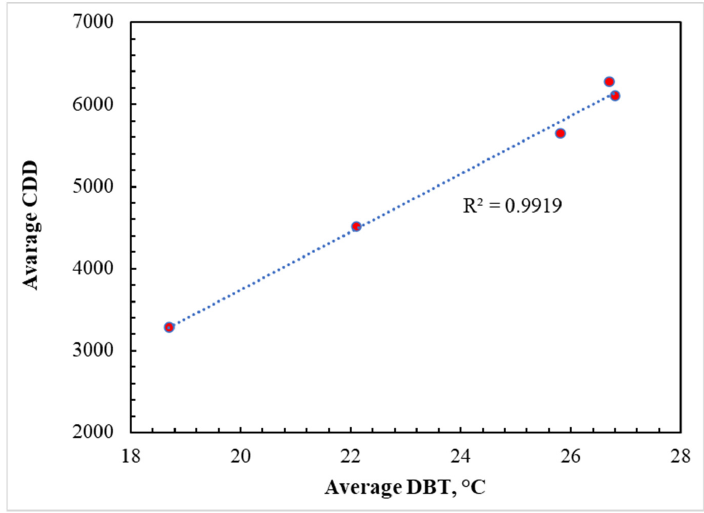
Figure 7. Correlation between DBT and CDD of the studied cities.